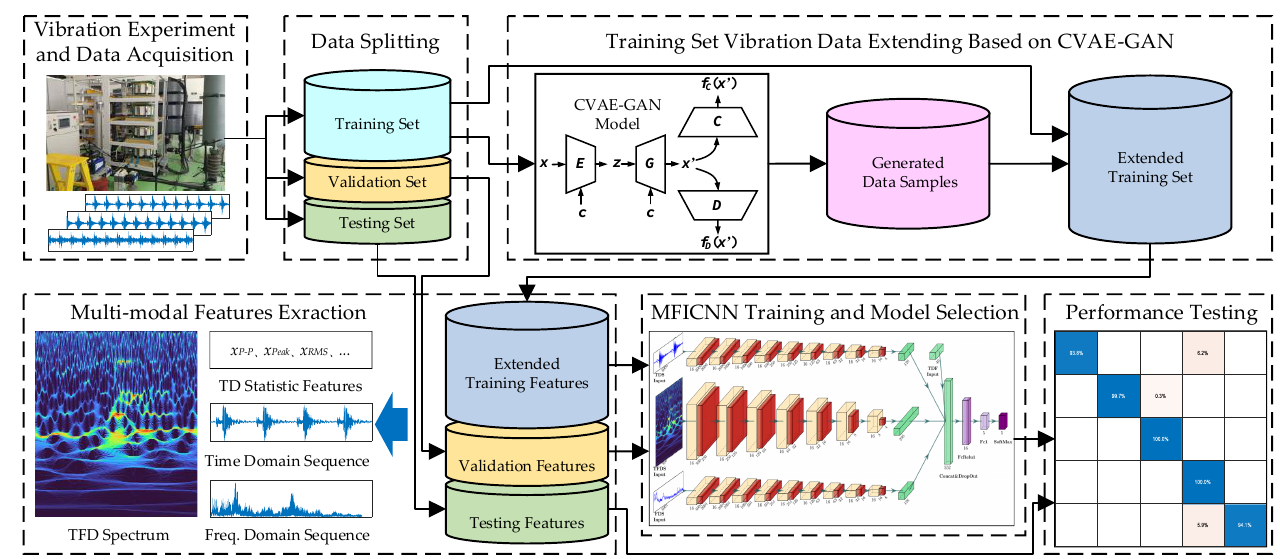
Figure 2. Framework of the proposed CVG-MFICNN diagnosis method.